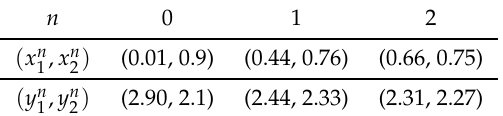
Table 18. Values of the iterated sequence ( x n , y n ) if started with (( 0.01,0.2 ) , ( 2.9,2.1 )) .